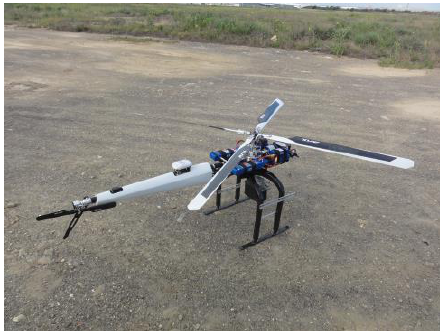
Figure 6 Proposed UAV helicopter